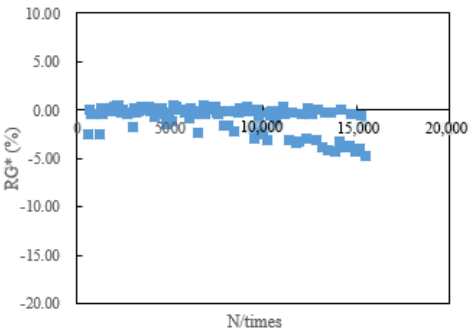
Figure 4. Evaluation result of N RG* under strain ‐ control.